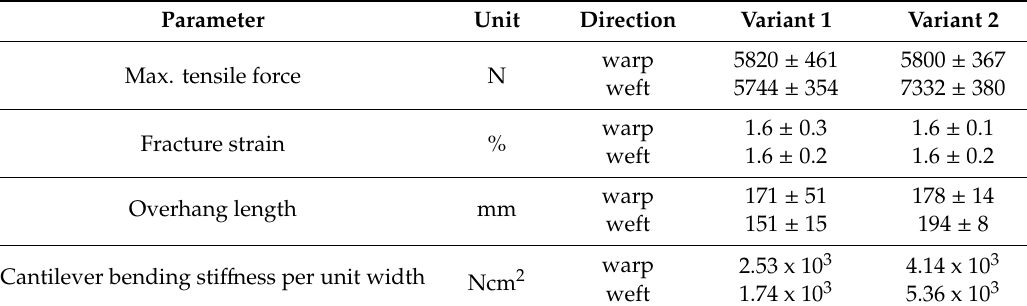
Table 3. Experimental test results of the two fabric variants.